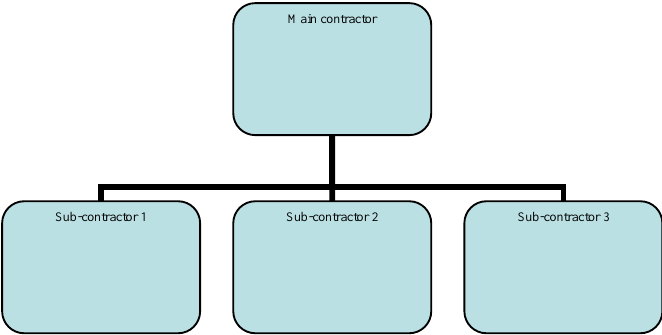
Figure 1 Traditional analysis of business management